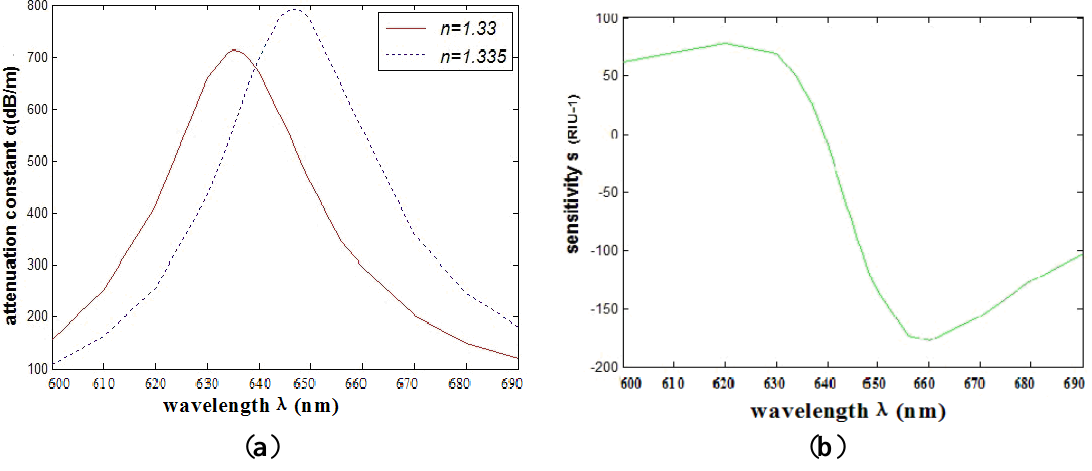
Figure 3. ( a ) Relationship between wavelength and attenuation constant of the fundamental mode of the grapefruit PCF occupied by one silver nanowire of 300 nm radius. The red and blue curves represent the refractive indices of the samples which are 1.33 and 1.335, respectively; ( b ) Intensity detection sensitivity ( RIU −1 )